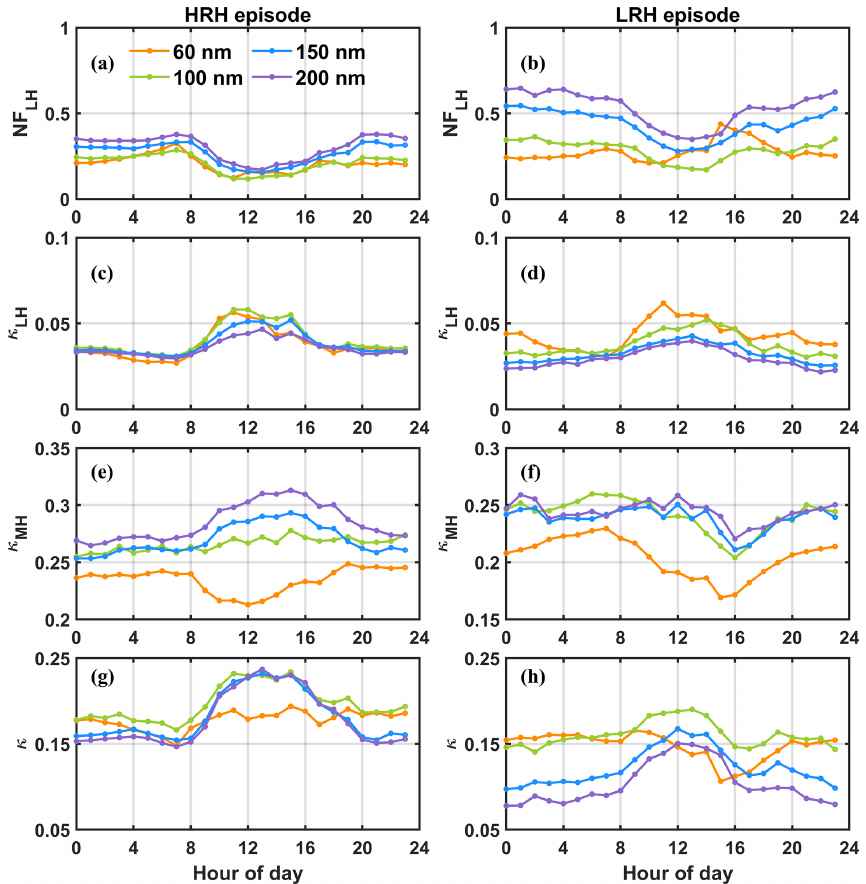
Figure 6. Diurnal variation of the number fractions and individual κ of LH and MH mode particles under these two